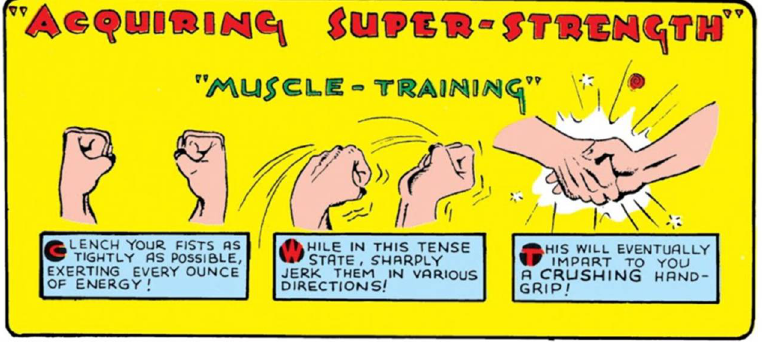
Figure 19. Joe Shuster, Closing Panel: “Acquiring Super-Strength” (panel No. 100), 1938. Siegel and Shuster (November 1938), “Superman”, Action Comics #6 (Siegel and Shuster 1938d, p. 86). © DC Comics.